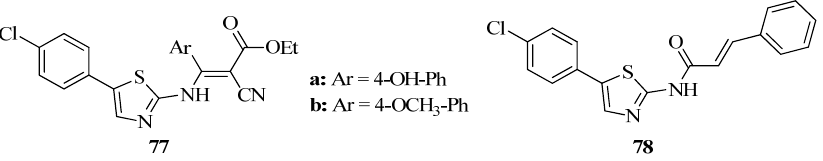
Figure 30. Structure of 2-(substituted)amino-1,3-thiazole derivatives.